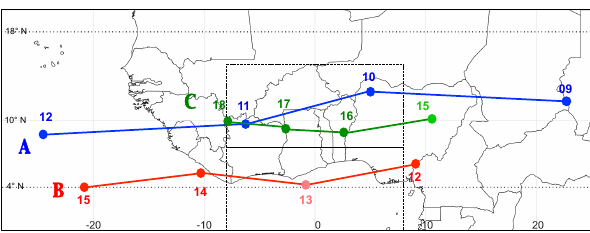
Figure 11. Significant synoptic-scale features during 9–18 June 2016 (Phase 1). To create this graph, vortices were subjectively identified in 850hPa streamlines based on operational ECMWF analyses. All vortex positions refer to 00:00UTC with the dates given as numbers. Round symbols mark cyclonic systems (labelled A, B and C). Paler colours are used for days when the vortices were not clearly identifiable. The boxes mark the areas used to compute the NSPD shown in Fig. 5a. The stippled lines show the latitude range used to produce Fig. 9. Figure 12. Extratropical influences during the monsoon onset.